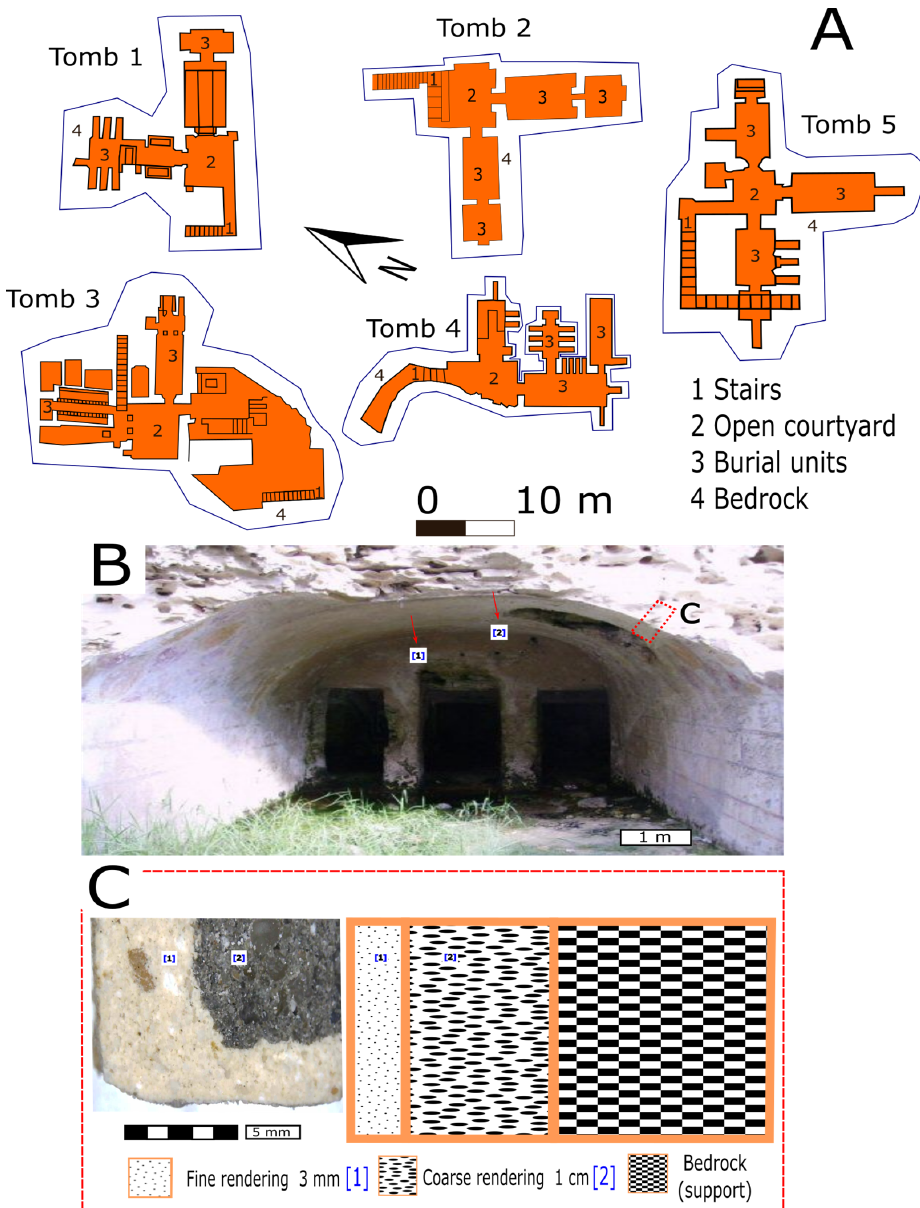
Figure 3. ( A ) Schematic plans for the five tombs of Anfushi’s Necropolis and their architectural elements of the rock-cut tombs and their elements. ( B ) General view the ground level of the tomb No 4 leads to the burial units and attached rooms. Numbers in square brackets and red rectangles refer to the image ( C ). ( C ) Cross-section for mortar of the tombs, which consists of the support wall (bedrock), coarse rendering mortar, and fine rendering mortar for painting.